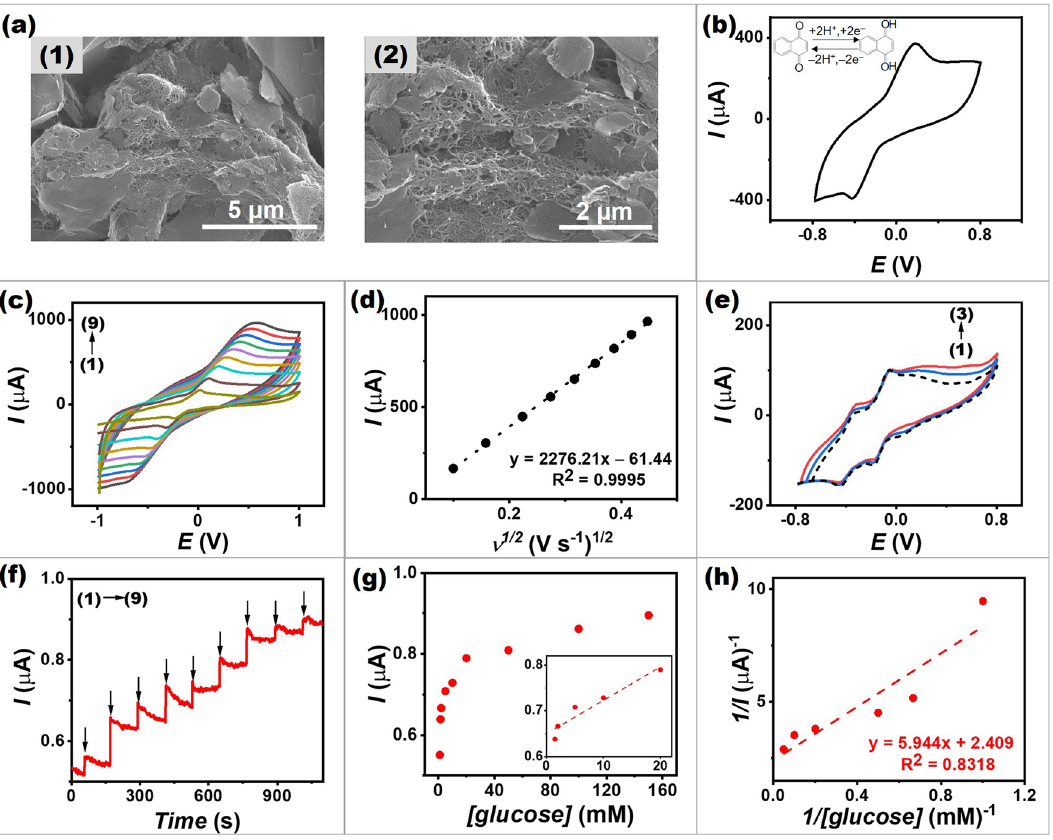
Fig. 2 Characterizations of the anode. a SEM images of a screen-printed NQ/MWCNT-based anode at (1) low and (2) high magnification. b CV obtained from a screen-printed NQ/MWCNT-based anode in 0.1 M PBS, pH 7.0 with a scan rate of 50 mV s −1 . c CVs obtained from a screen-printed NQ/MWCNT-based anode in 0.1 M PBS, pH 7.0 at different scan rates from 10 to 200 mV s −1 (scan rates (1–9): 10, 25, 50, 75, 100, 125, 150, 175 and 200 mV s −1 ). d Plots of anodic peak current densities in function with square root of the scan rate obtained on a screen- printed NQ/MWCNT-based anode. e CVs obtained from a screen-printed GOx/NQ/MWCNT-based bioanode in (1–3) 0, 10, and 100 mM glu- cose in 0.1 M PBS, pH 7.0 with a scan rate of 5 mV s −1 . f Amperometric response of a screen-printed GOx/NQ/MWCNT-based bioanode with an applied potential of 0.3 V versus Ag/AgCl upon increasing the glucose concentrations ((1) 1.0 mM; (2) 1.5 mM; (3) 2.0 mM; (4) 5.0 mM; (5) 10 mM; (6) 20 mM; (7) 50 mM; (8) 100 mM; and (9) 150 mM). g The corresponding calibration plot of the current response of the GOx/NQ/ MWCNT-based bioanode. h The double reciprocal plot of the calibration curve obtained from the GOx/NQ/MWCNT-based